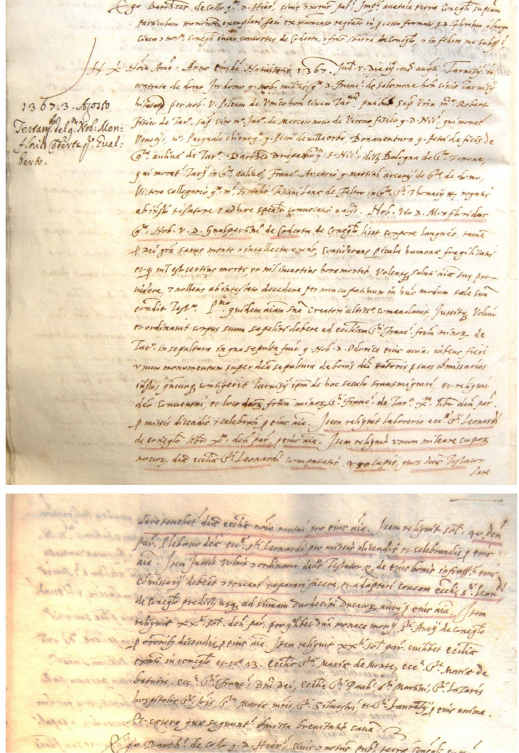
Figure 7. An ancient document (1367) containing a full donation description made by Monflorido Coderta to the Confraternity of Battuti. Church’s